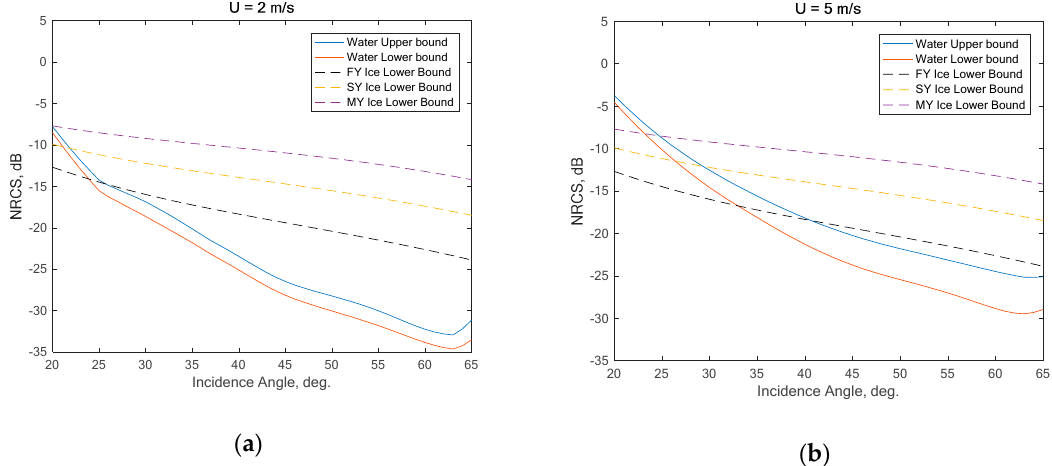
Figure 3. Positional relationship of the sea ice lower boundaries for FY, SY, and MY ice at the NH and water NRCS upper and lower boundaries at low wind speeds depending on an incidence angle from 20° to 65°: ( a ) wind speed of 2 m/s; ( b ) wind speed of 5 m/s.